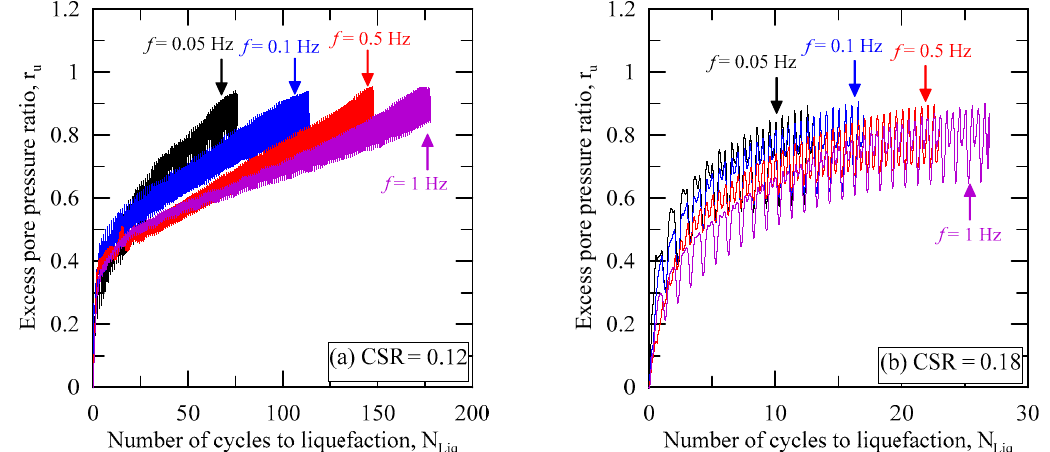
Figure 11. Accumulation of excess pore pressure under different shear values ( a ) CSR = 0.12 and ( b ) CSR = 0.18 effected by loading frequencies for loose sand at σ v0 ′ = 200 kPa.